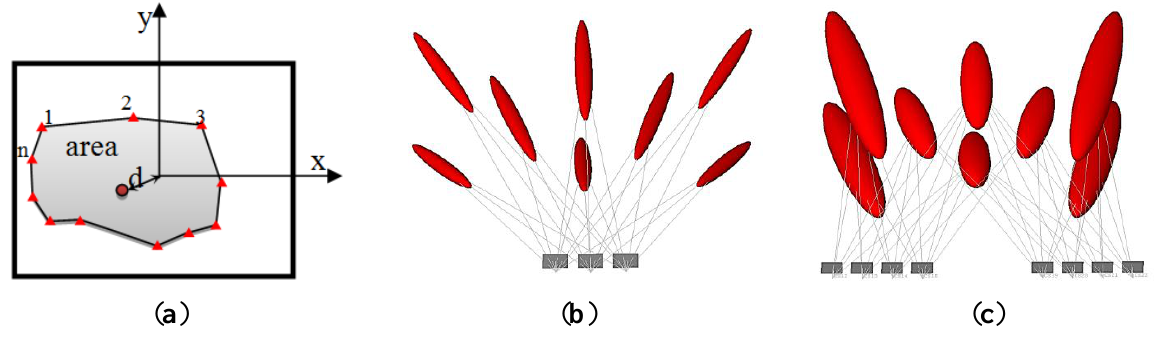
Figure 4. Estimated uncertainty in the object space with ellipsoid of errors. ( a ) Sketch of the input measures in image plane; ( b ) Overall vector of precision is 5.2 mm; ( c ) Overall vector of precision is 6.3